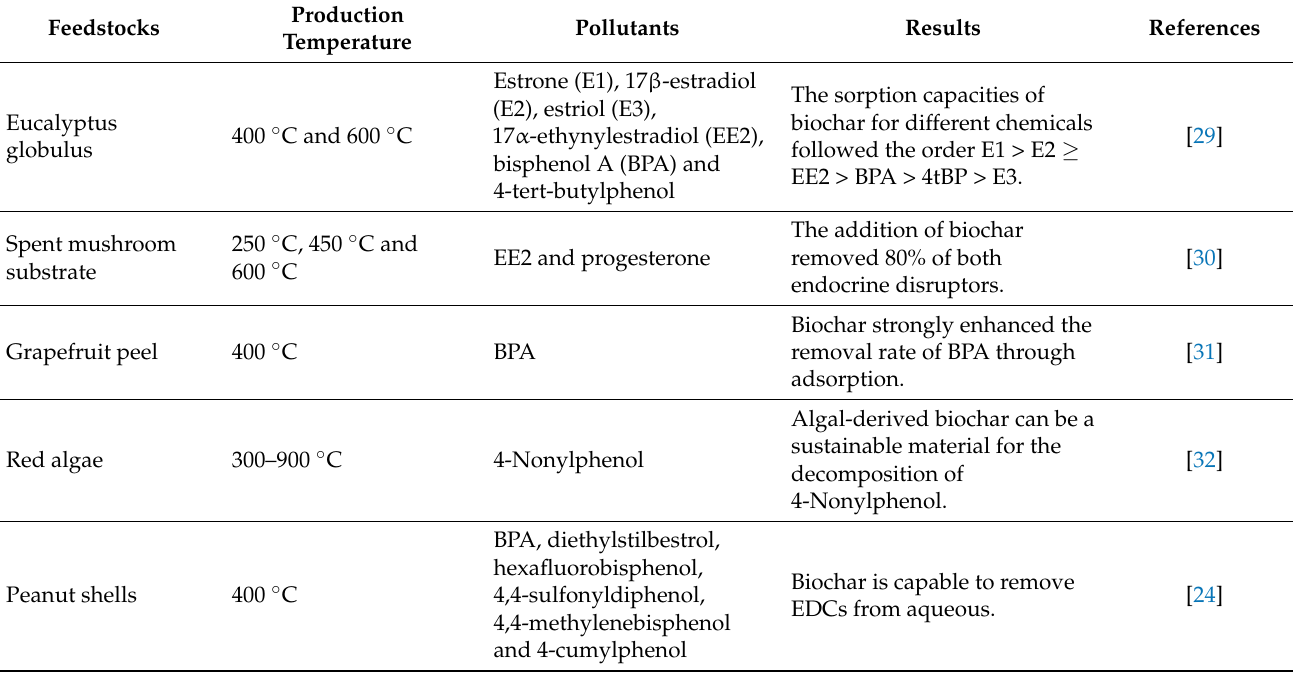
Table 1. Representative studies on the removal of endocrine-disrupting chemicals from aquatic systems by